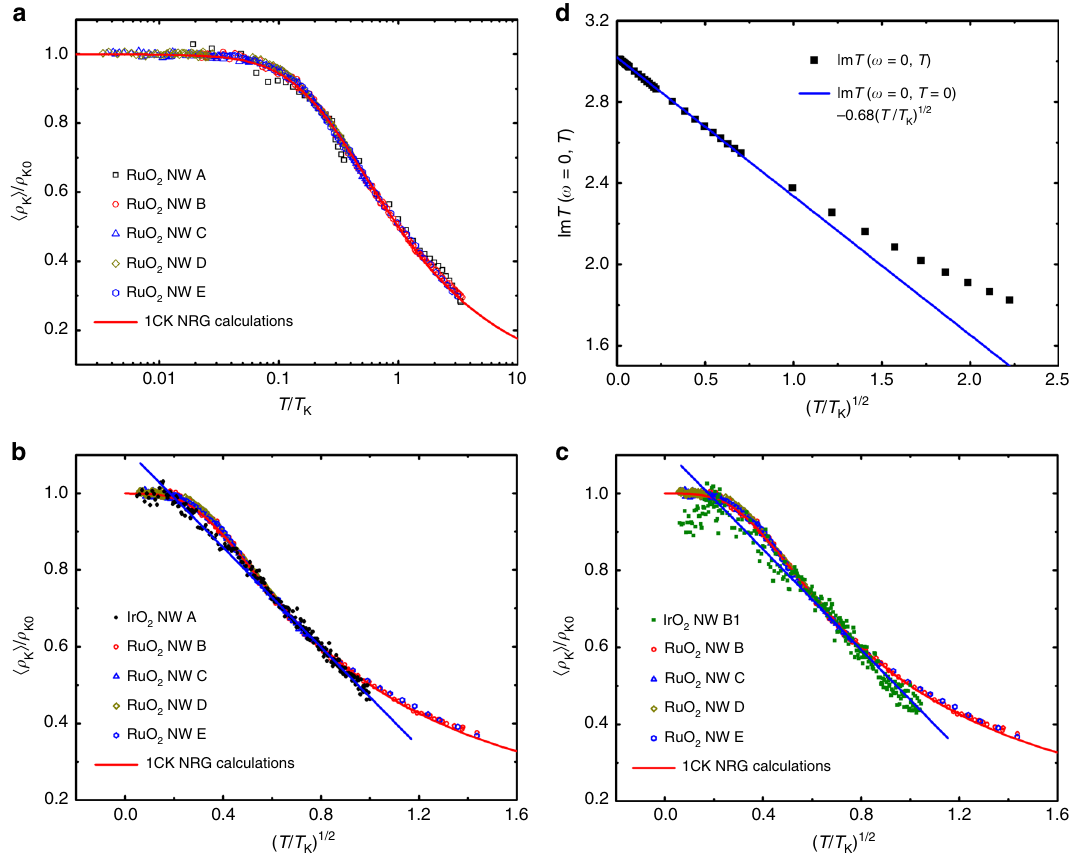
ffiffiffiffiffiffiffiffiffiffiffi p T = T for IrO 2 NW A and RuO 2 NWs B – E. The data of IrO 2 NW A obeys a ffiffiffi K ffiffiffiffiffiffiffiffiffiffiffi p T = T law at low T (see text and Supplementary Note 5). The K